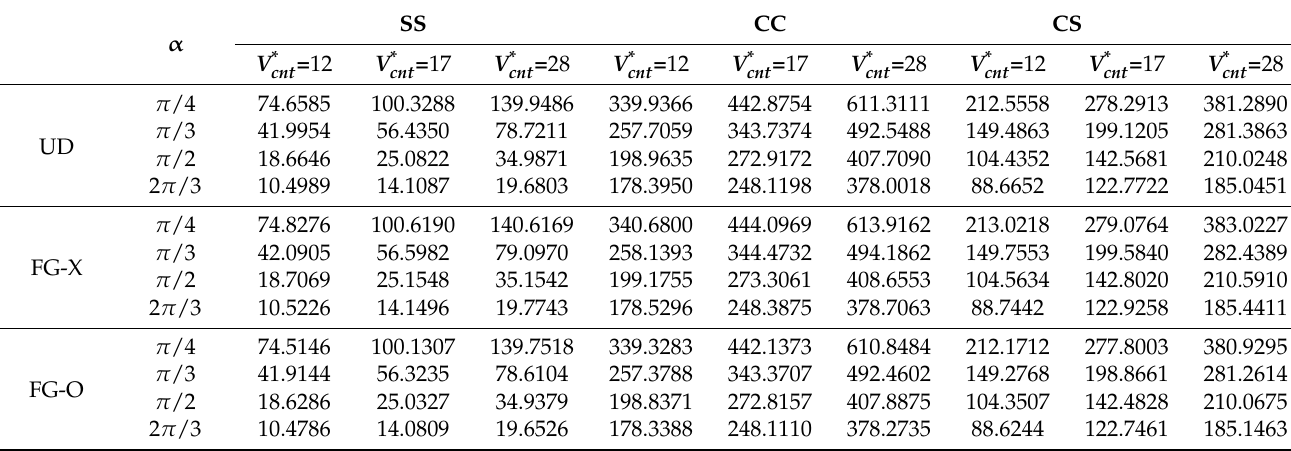
Table 6. Effect of opening angle on the dimensionless buckling load of curved sandwich beam ( 0 ◦ /90 ◦ / c /90 ◦ /0 ◦ ) ( h c / h f = 4, h = L /10, T = 300 K.